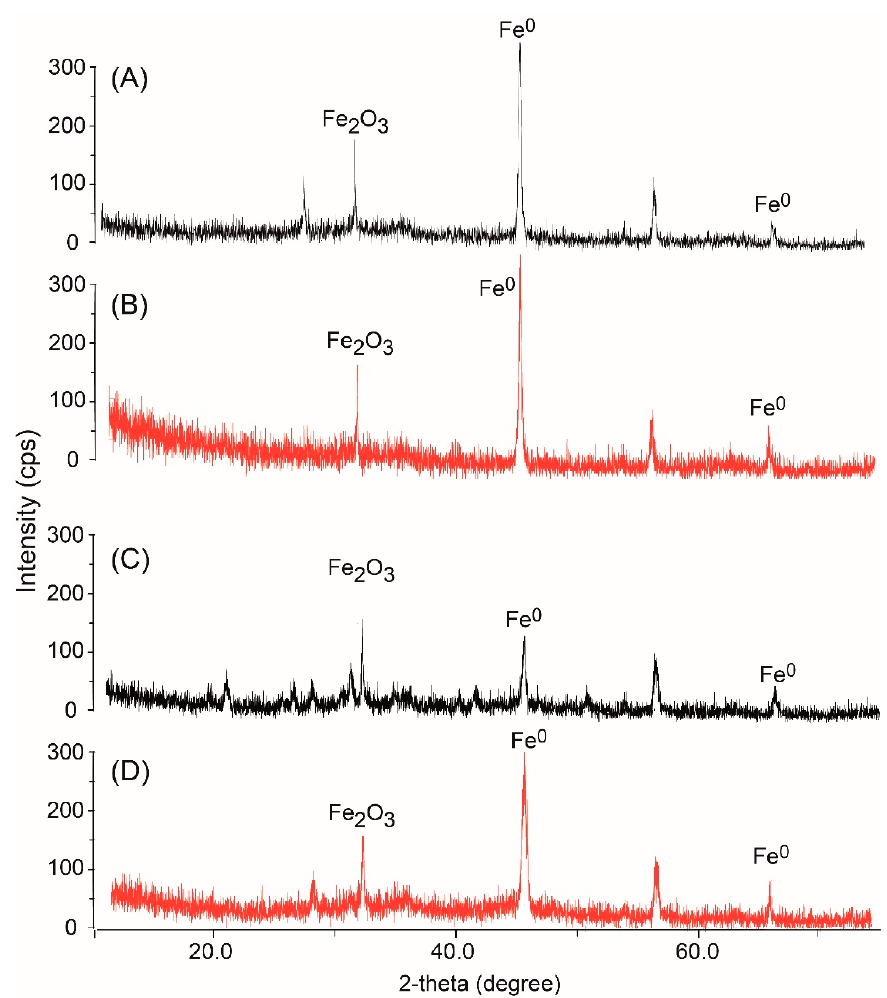
Figure 1. X ‐ ray diffraction (XRD) patterns of ( A ) bare nanoscale zero ‐ valent iron (nZVI), and ( B ) carboxymethyl cellulose (CMC)–nZVI at time of preparation; and of ( C ) bare nZVI and ( D ) CMC–nZVI, aged for 30 days.